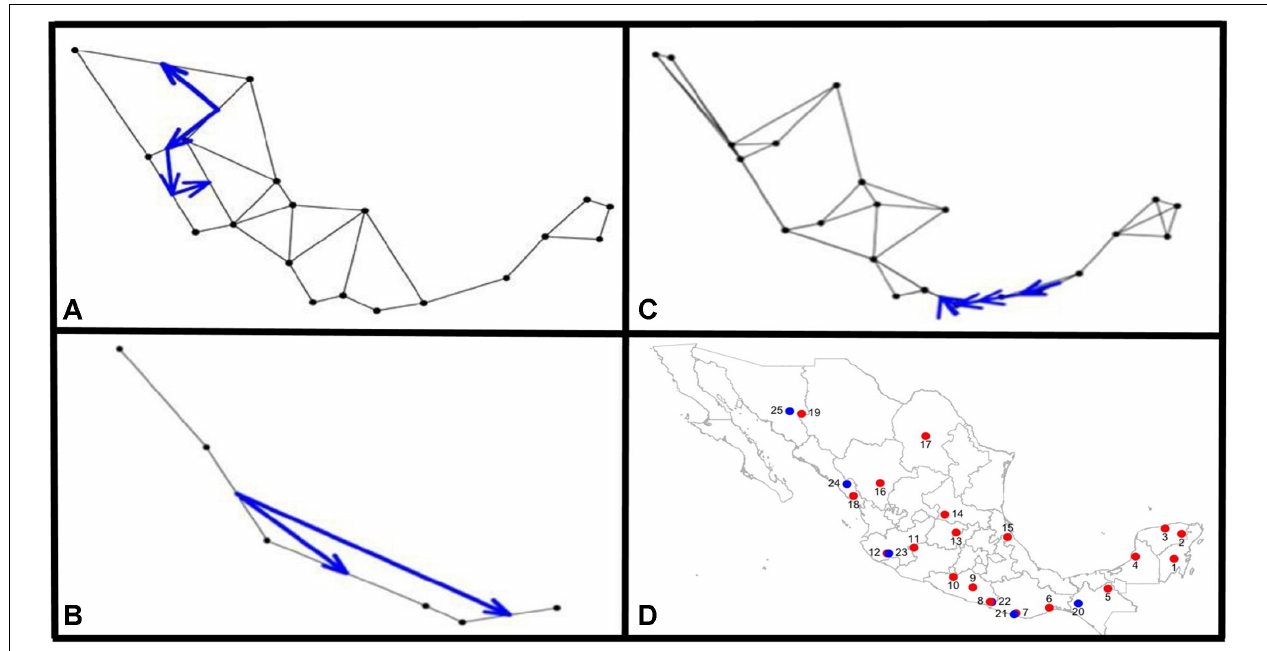
FIGURE 9 | Results from the Monmonier analysis performed with adegenet Black dots represent sampled populations and blue arrows depict significant barriers to gene flow, for (A) C. argyrosperma ssp. argyrosperma , (B) C. argyrosperma ssp. sororia , (C) both subspecies. (D) Location of populations on a map, blue dots corresponding to C. argyrosperma ssp. sororia and red dots are C. argyrosperma ssp. argyrosperma . Population ID is shown in Table 1